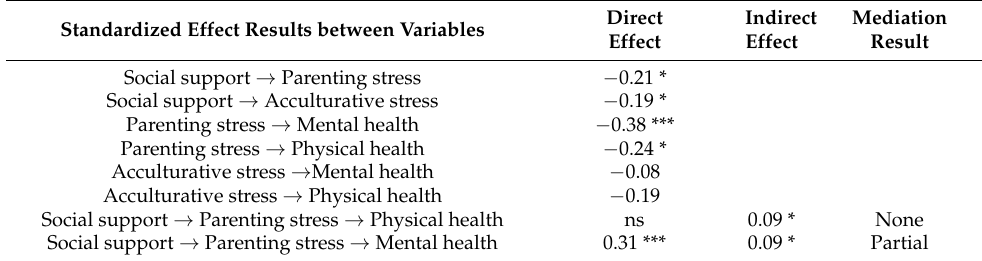
Table 3. Summary of standardized effect results for the structural model ( n =